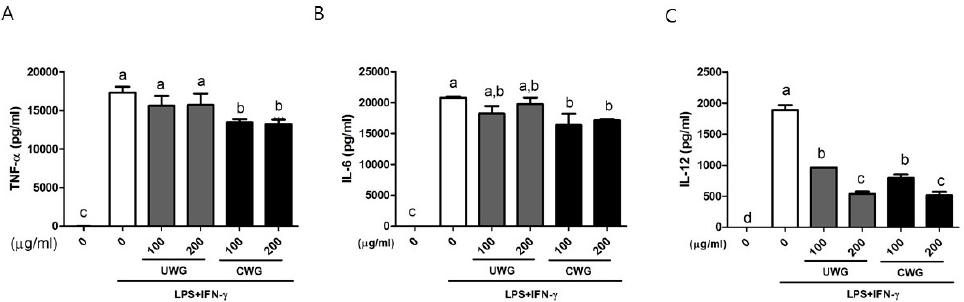
Figure 3. Effect of CWG on the secretion of tumor necrosis factor (TNF)- α , interleukin (IL)-6, and IL- 12. Mouse peritoneal macrophages were stimulated with LPS plus IFN- γ in the presence of UWG or CWG for 24 h, and the levels of TNF- α ( A ), IL-6 ( B ), and IL-12 ( C ) in the supernatant were analyzed by ELISA. Data are expressed as mean ± SD ( n = 3). Different letters indicate statistical significances ( p < 0.05).